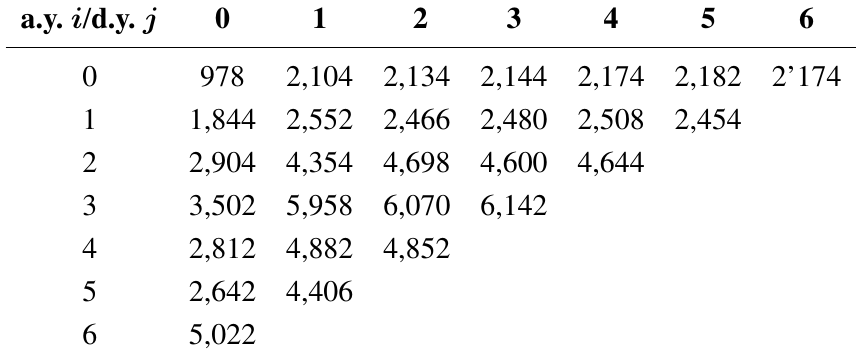
, i + j ≤ 6 , source Quarg and Mack i,j